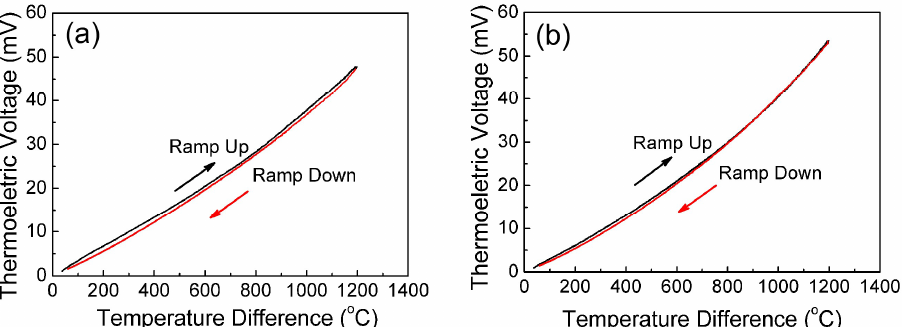
Figure 5. Thermoelectric voltage of In 2 O 3 /ITO thermocouple as a function of temperature difference: ( a ) without glass additives; ( b ) with 8 wt % glass additives. Table 1. Polynomials used to describe the thermoelectric output of In 2 O 3 /ITO thermocouples with different glass additives .